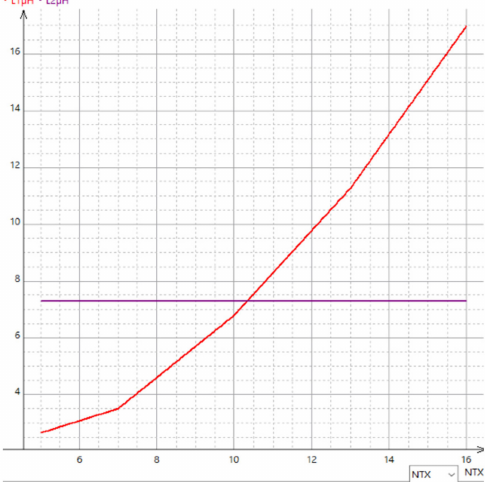
Figure 21. Number of turns simulation results of circular coil model: L 1 in the function of N TX , L 2 in the function of N TX